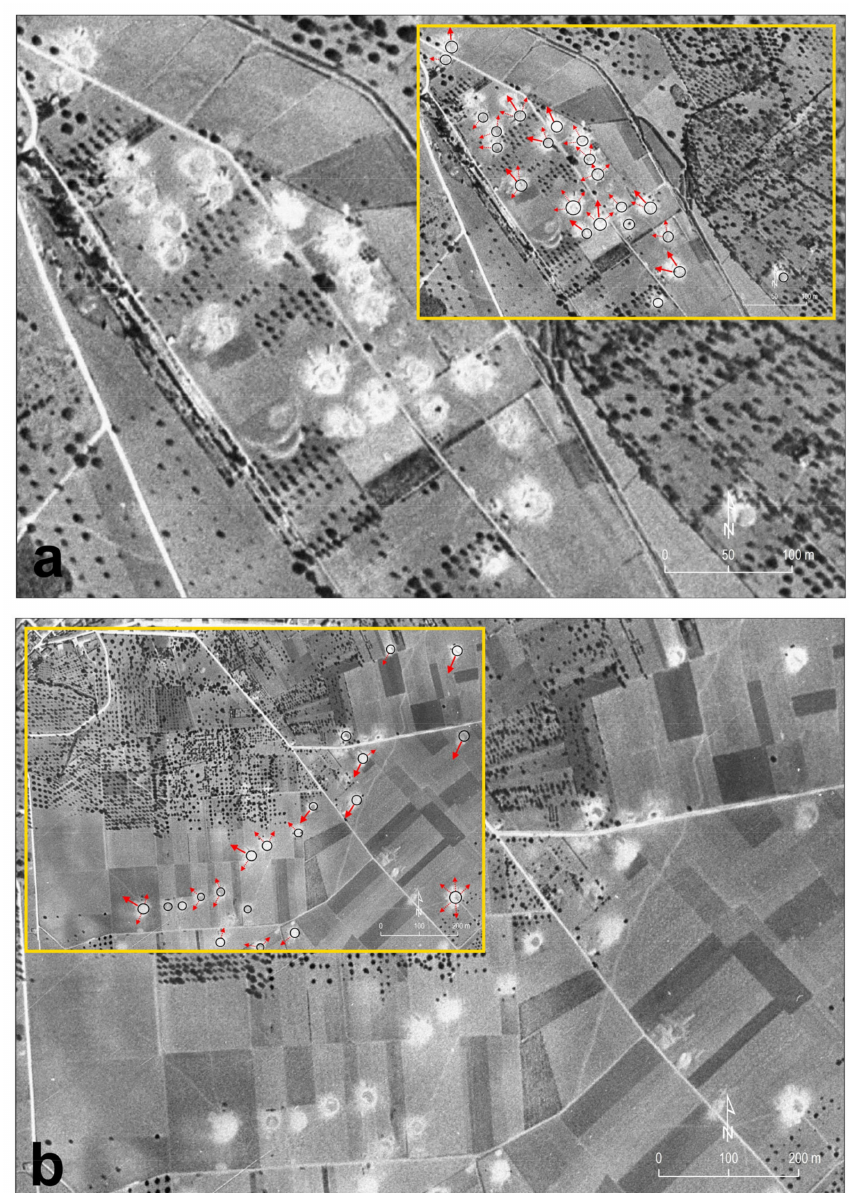
Figure 8. Examples of morphological aspect of threshing floors observed from the air and in two dimensions, according to the prevailing wind direction in the place, and its resultant ‘anemograph’; ( a ) south of the village of Sant Llorenç, situated in the oriental side of the island; ( b ) south of the village of Ariany, situated in the central plain.